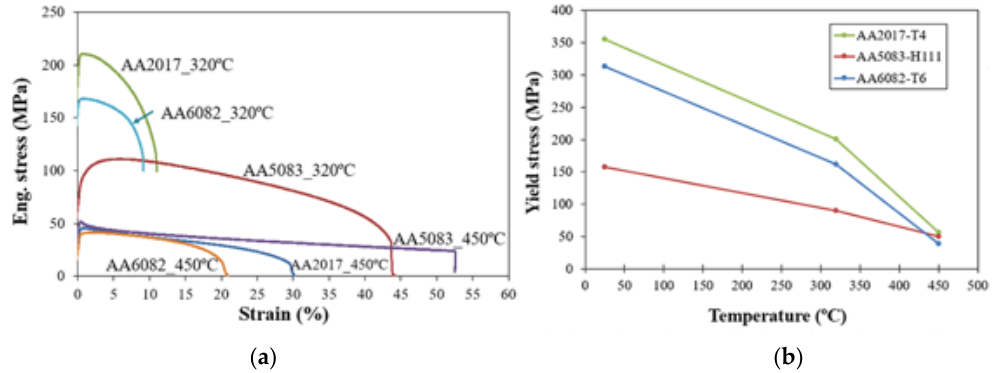
Figure 7. Variation of the mechanical properties of base materials with temperature: ( a ) Engineering tensile stress–strain curves and ( b ) yield stress curves.